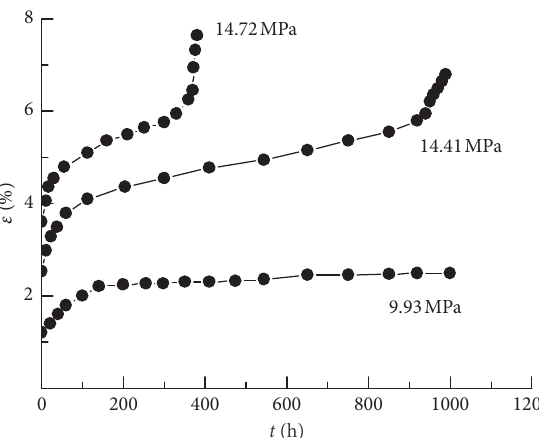
Figure 4: Axial creep curves for Changshan rock salt.